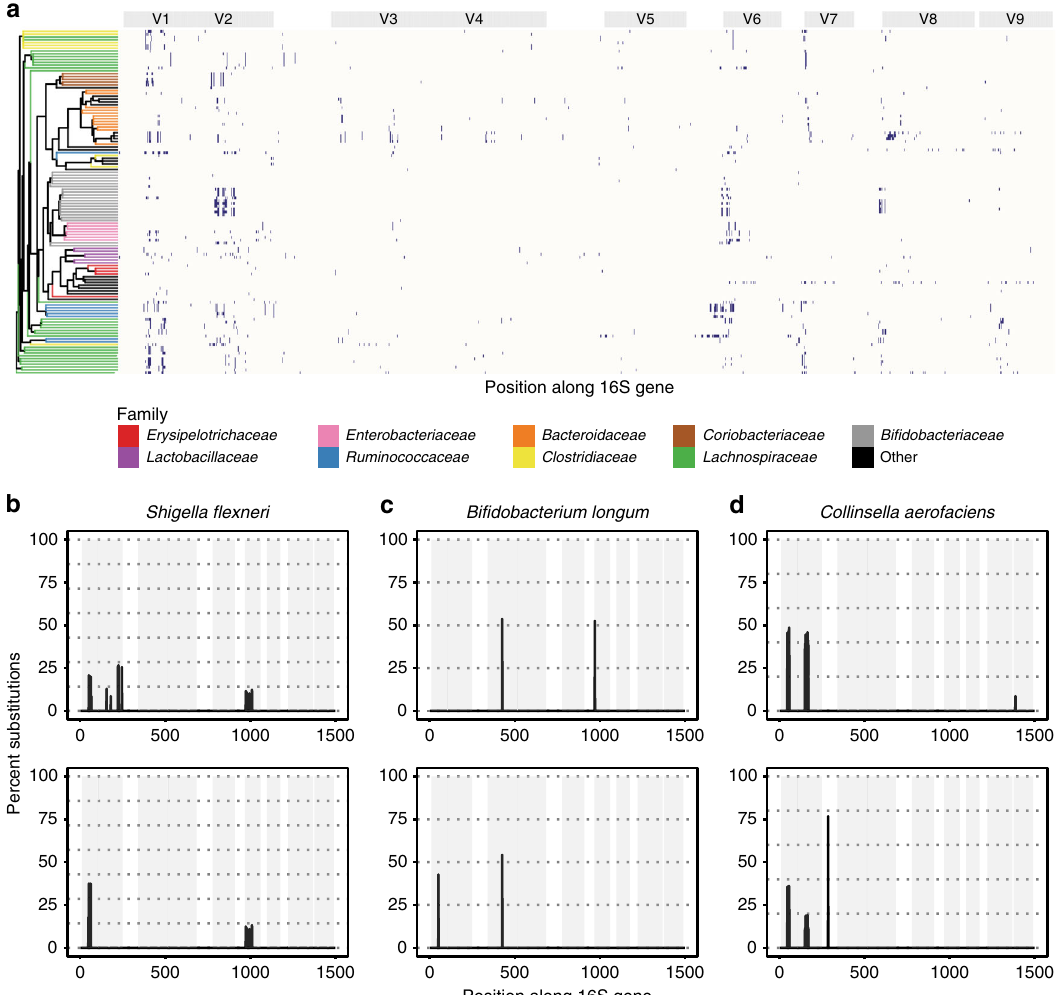
Fig. 4 Intragenomic 16S gene polymorphisms in human gut microbiome isolates. a Location of SNPs present in the 16S genes of individually cultured bacterial isolates. SNP locations were identi fi ed through phasing full-length 16S gene sequences generated for each individual isolate. X -axis denotes position along the 16S gene. Y -axis denotes individual isolates clustered based on their inferred phylogeny. Dark blue region indicates the location of a polymorphism. For clarity, a maximum of fi ve isolates belonging to the same species are shown. For details of nucleotide substitution pro fi les for all sequenced isolates, see Supplementary Data 2. b – d Examples of nucleotide substitution pro fi les showing strain-level differences between isolates identi fi ed as belonging to three bacterial species: b Shigella fl exneri ; c Bi fi dobacterium longum ; d Collinsella aerofaciens . For each species, two isolate nucleotide substitution pro fi les are shown; however, additional examples can be found in Supplementary Data 2. Isolates were identi fi ed as belonging to the same performed using BLAST to align representative sequences to the NCBI 16S BLAST database (see Methods). Gray panels depict variable regions de fi ned